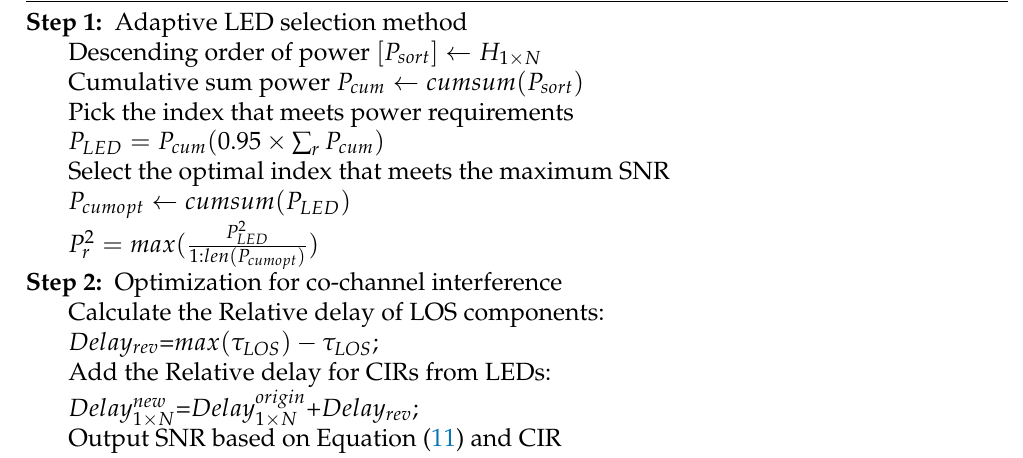
Algorithm 1 A two-step approach to optimizing multipath